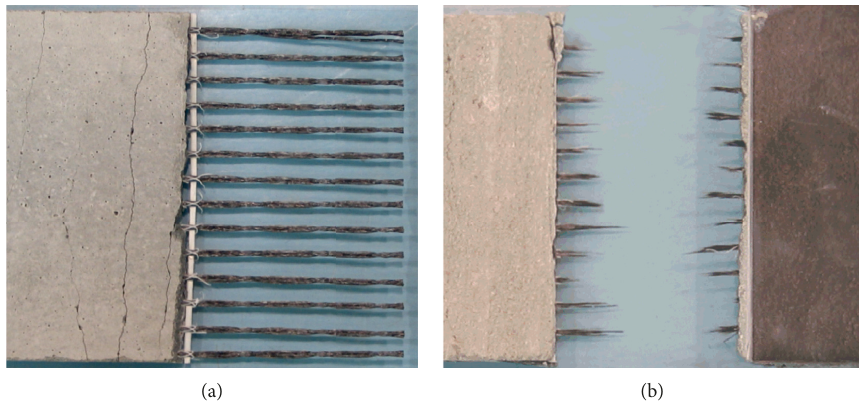
Figure 8: Obtaining the development length of rectangle-shaped specimen. (a) Pullout failure and (b) tensile failure.